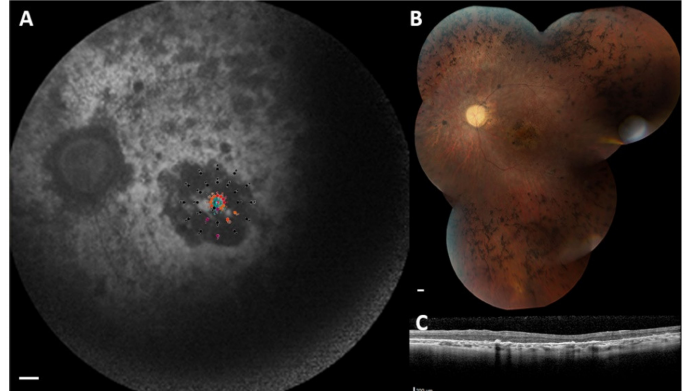
Figure 3. Multimodal imaging and microperimetry in the left eye of patient G-8 (best-corrected visual acuity of the left eye: 0.10). ( A ) Microperimetry revealed reduced, but measurable sensitivity (red and orange sensitivity points) at the central 2 ◦ of the fovea, with nearly a complete absence of sensitivity outside this region (black sensitivity points). Superimposed microperimetry data on the fundus autofluorescence (FAF) image demonstrated that loss of retinal sensitivity on microperimetry aligned with hypo-autofluorescent lesions on FAF. Scale bar = 1 mm. ( B ) The corresponding fundus image showed clinical hallmarks of retinitis pigmentosa and macular atrophy. Scale bar = 1 mm. ( C ) Spectral-domain optical coherence tomography (SD-OCT) showed remnants of the outer retina at the (para)fovea. Scale bar = 200 µ